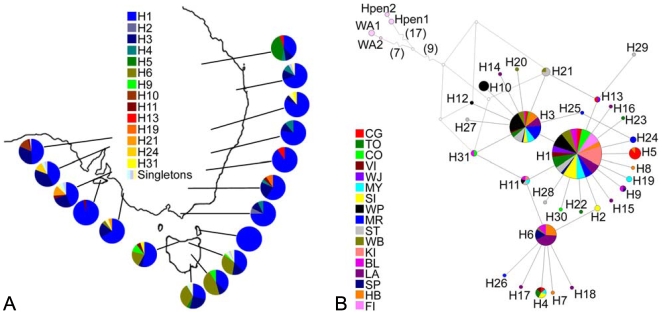
Relationships among haplotypes and collection sites.(A) Distribution of ND5 haplotypes amongst collection sites. Haplotypes are labelled by colour and the frequency at each site is indicated in pie charts. H1 (bright blue) is present at all sites and H7-H8, H12-H18, H20, H22-H23, and H25-H30 (represented in three pastel colours for simplicity) are present in a single individual each. (B) Median Joining network indicating the relationship amongst ND5 haplotypes. Each pie chart represents a different haplotype, made up of collection sites in which that haplotype occurs (sites labelled by colour). Haplotypes connected by a line differ in sequence by one base pair. The size of each pie chart indicates the relative frequency of the haplotype within the entire sample. The size of the collection site slices is influenced by both the frequency of the haplotype across the sites and the sample size for each site. As sample sizes are not equal (Table 1), slices may be interpreted as indication of presence of a haplotype at a site rather than frequency. The network shown is estimated as being connected to outgroups H. m. duboulayi (WA1 and WA2) and H. penelope (Hpen1 and Hpen2) via inferred common ancestors of H12, H21, and H31 (open circles).